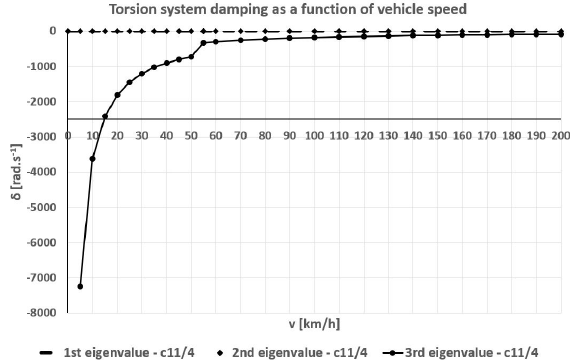
Figure 21. Damping as a function of velocity – c